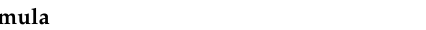
Table A20. Model selection procedure by “all subsets”, according to AICc, from the full model of the relationship between the 15 climate variables and the year, and the overall timing of migration as measured by Annual Anomaly (AA) for the Lesser Whitethroat Curruca curruca caught at Bukowo, Poland, in 1982–2017. Symbols as in Table A19. The best model, discussed in the text, in bold face.